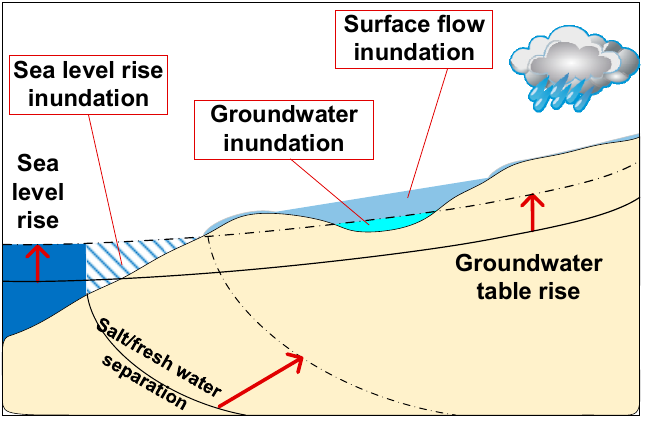
Figure 2. Schematic of emerging sources of inundations in coastal areas under a changing climate.